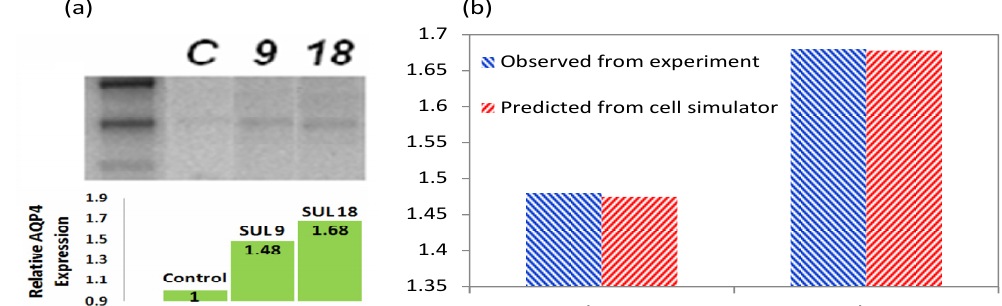
9 h of continuous exposure, and 68% upregulation after 18 h compared to control ( a ); Cell simulator results agree with measured expression levels of AQP4 ( b